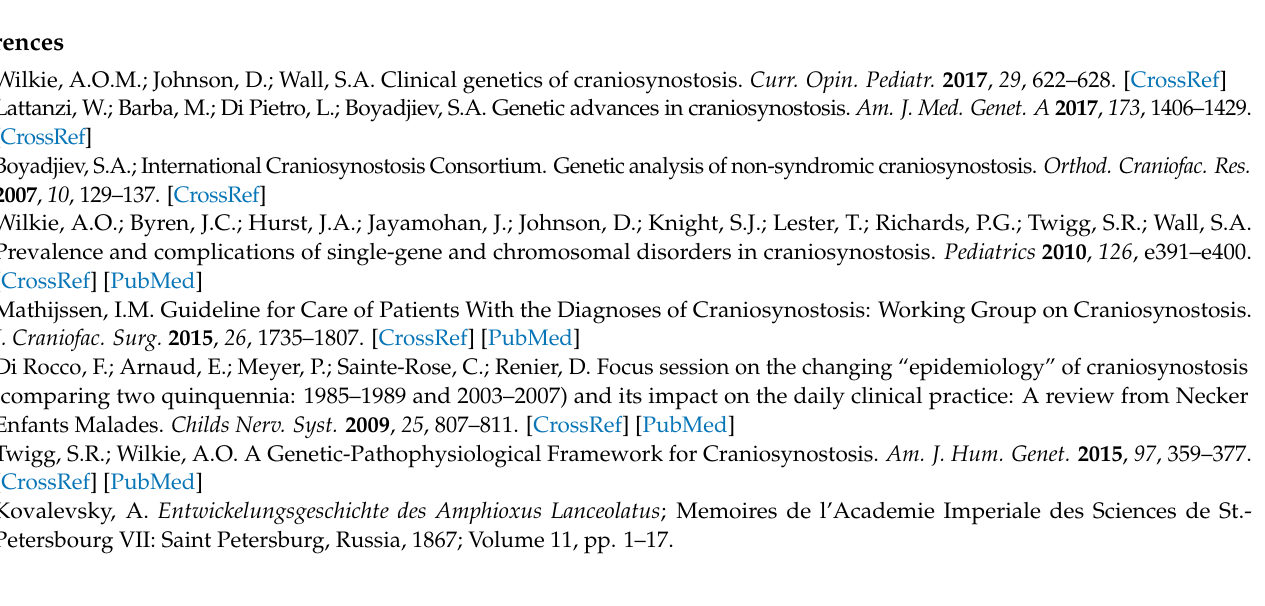
Table S4: GO annotations enrichment—process; Table S5: CytoScape enrichment for primary cilium related